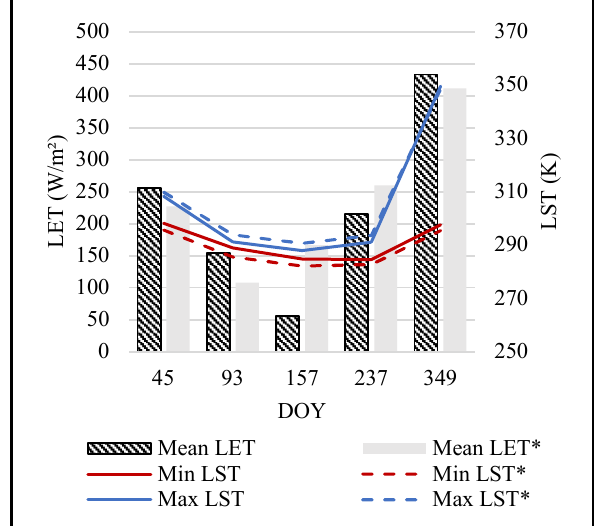
Figure 5. Mean, Minimum and Maximum Land Surface Temperature (LST, Kelvin) and Latent Heat Flux (LE, W/m²) of